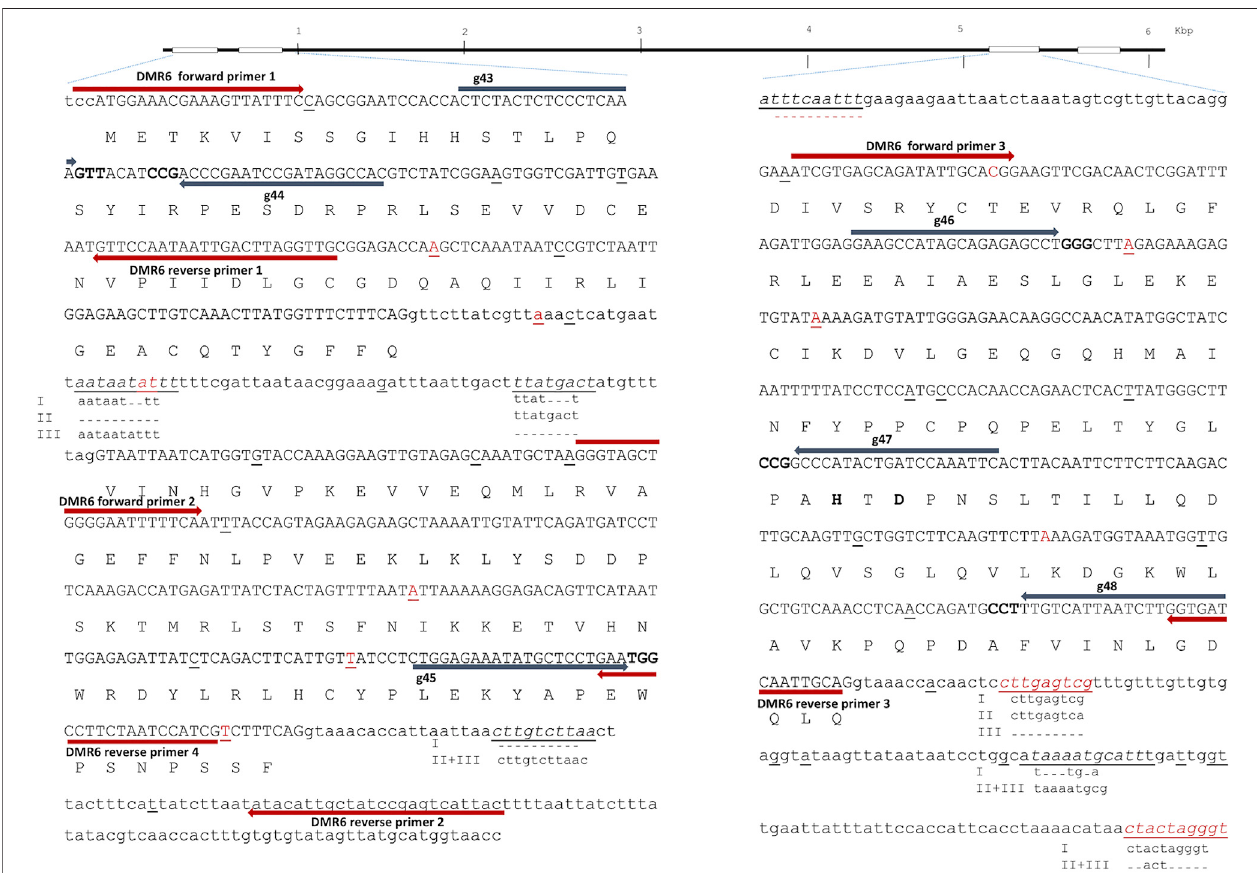
Frontiers in Genome Editing |